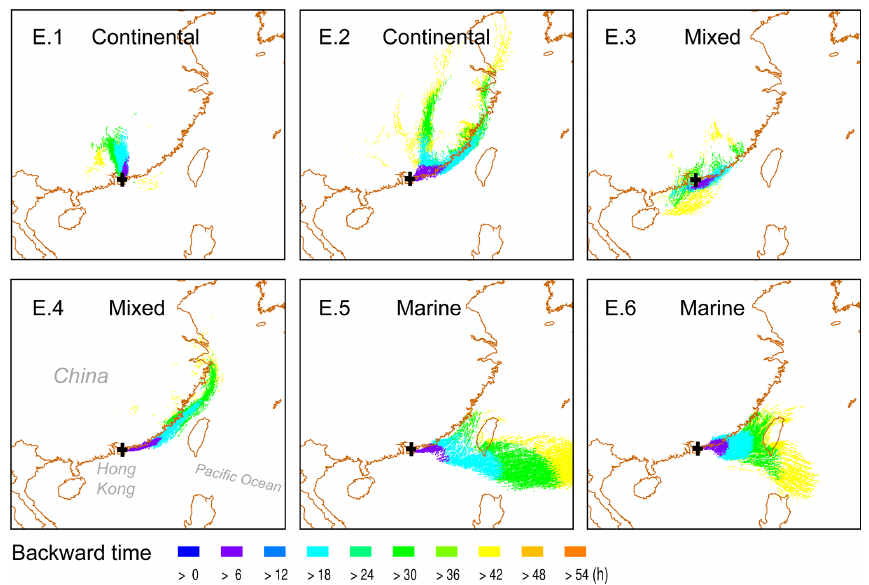
Figure 1. Air mass plumes arriving at TMS (black cross) in Hong Kong for six cloud events (E.1–6) simulated using the HYbrid Single- Particle Lagrangian Integrated Trajectory model. The model was driven by archival meteorological data from the Global Data Assimilation System (GDAS; 1 ◦ × 1 ◦